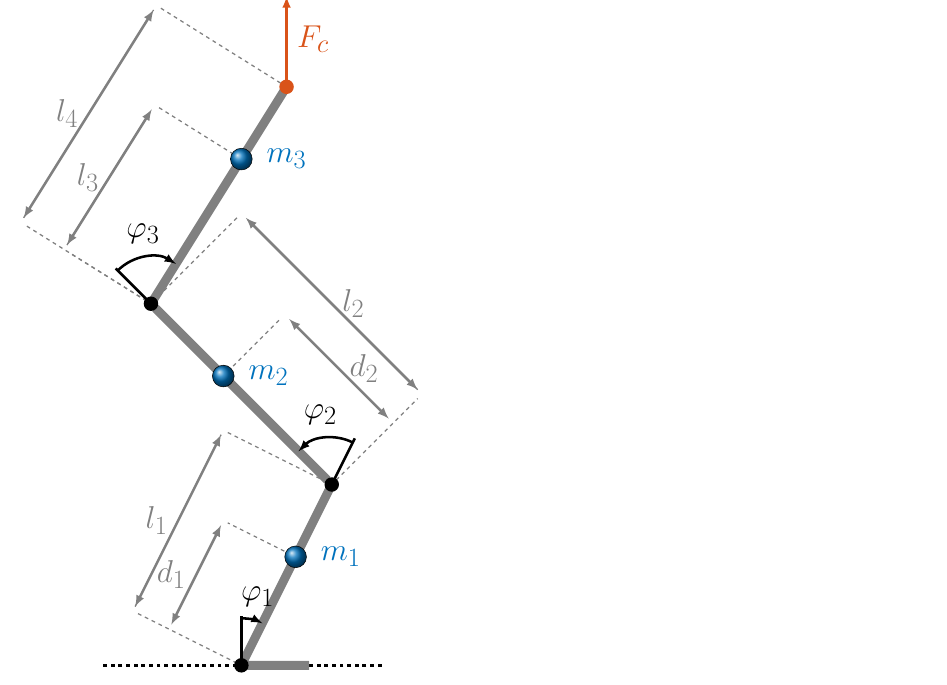
Figure 8. Visualization of a reduced model for sit-to-stand and stand-to-sit motion modeled as a triple inverse pendulum with point masses, with the assumption that both hip and knee joints move